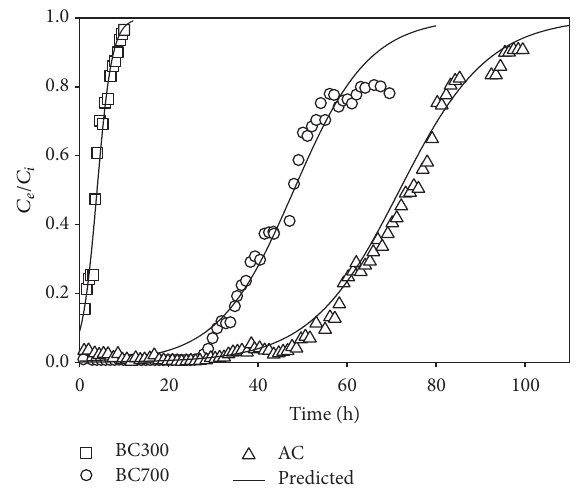
Figure 1: Breakthrough curves for adsorption of trichloroethylene (TCE) onto biochar derived from soybean stover at 300 ∘ C (BC300) and 700 ∘ C (BC700) and activated carbon (AC). Solid line represents data predicted by the Thomas model.